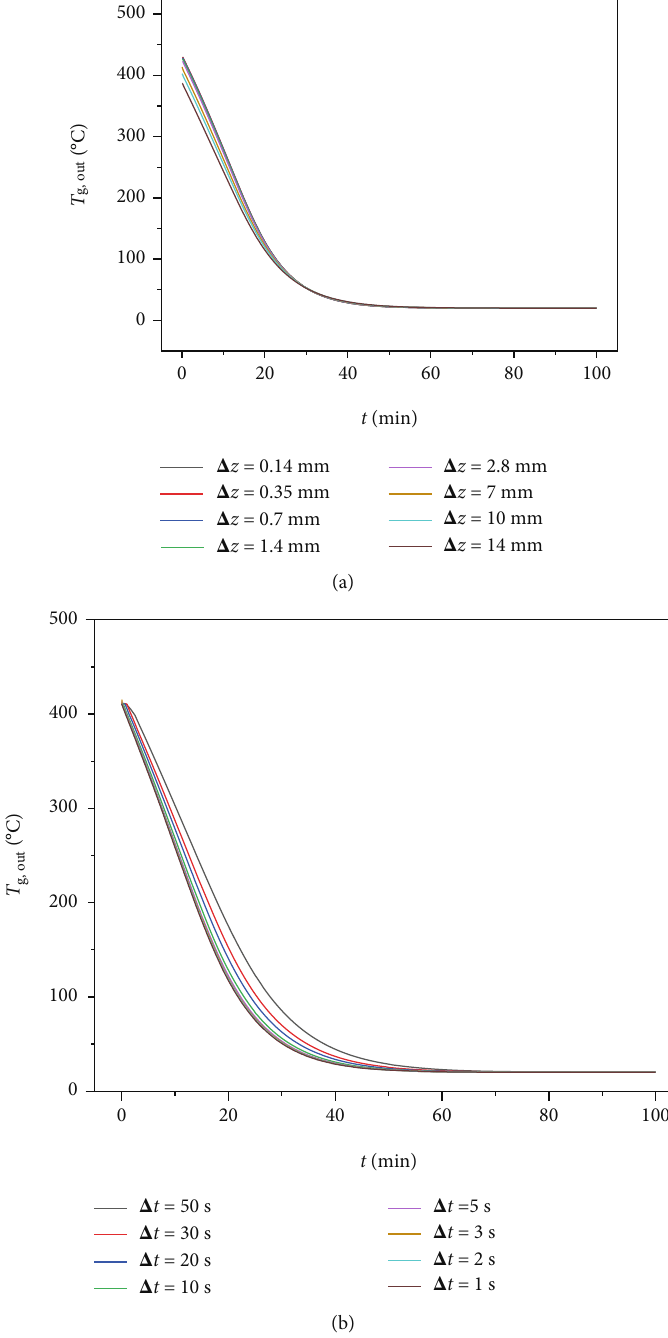
Figure 6: The change of the gas outlet temperature T